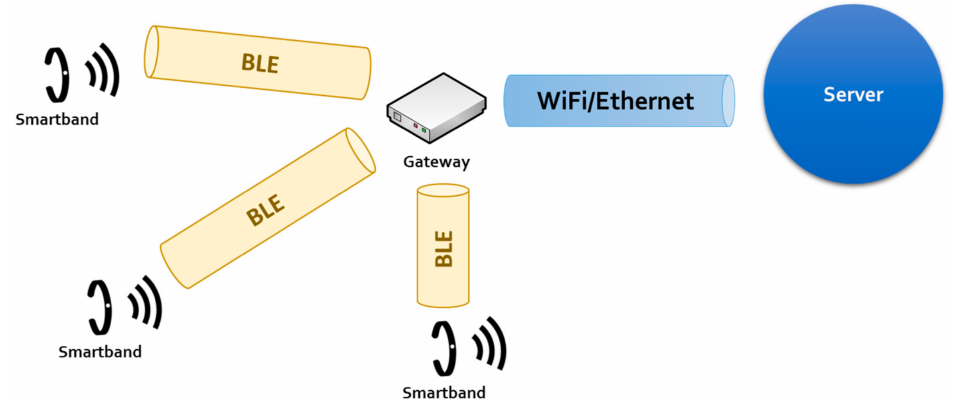
Figure 3. Centralisation module.